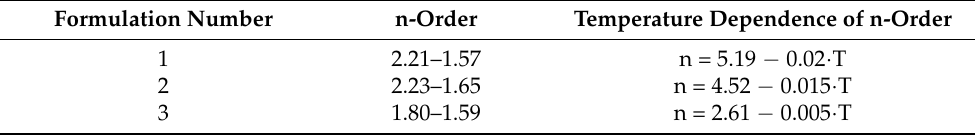
Table 7. The values of rate constant (k n-ord ) and activation energy (E n-ord ) of zone 2 for compositions 1–3. Formulation